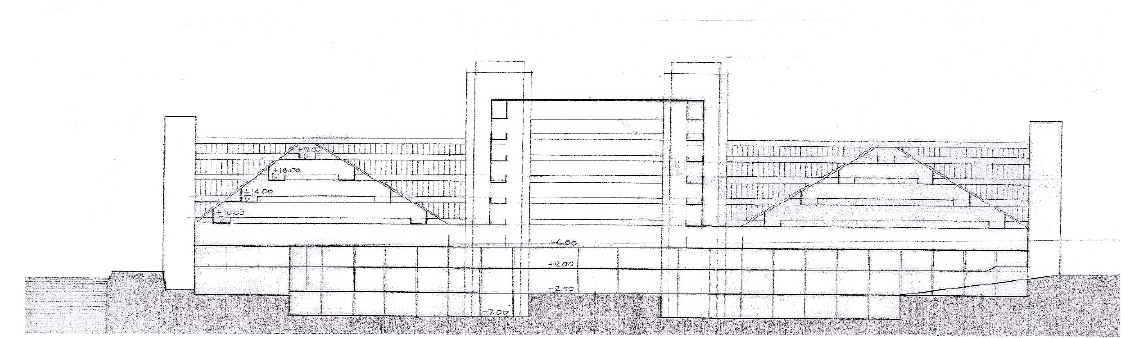
Figure 8. Section CD, Hestnes Ferreira proposal (source: Marques da Silva Foundation, RHF